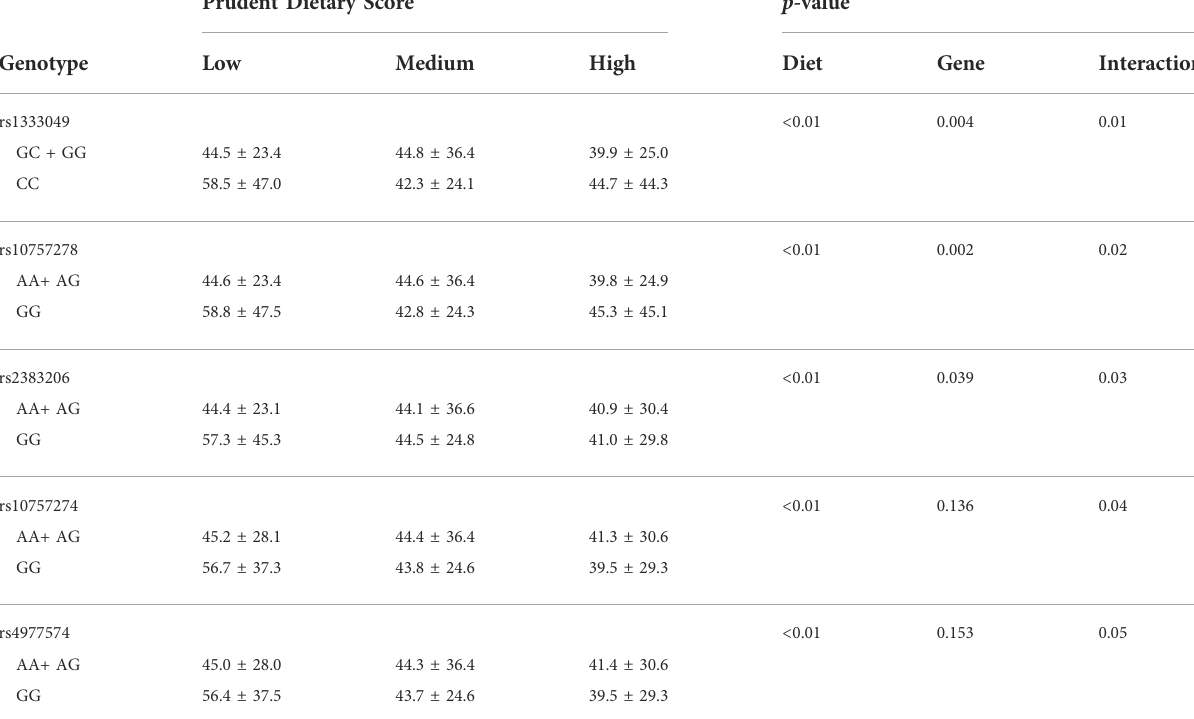
TABLE 3 Fasting insulin by 9p21 genotype, and prudent dietary score.